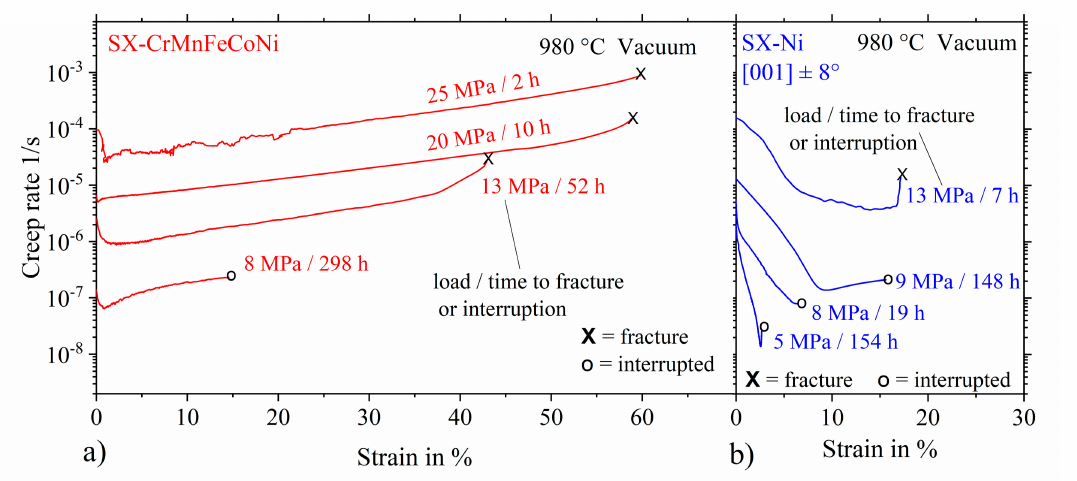
Figure 4. Creep rate over strain diagram for the creep tests of the single crystalline ( a ) CrMnFeCoNi alloy, and ( b ) pure nickel at 980 ◦ C and at di ff erent loads under